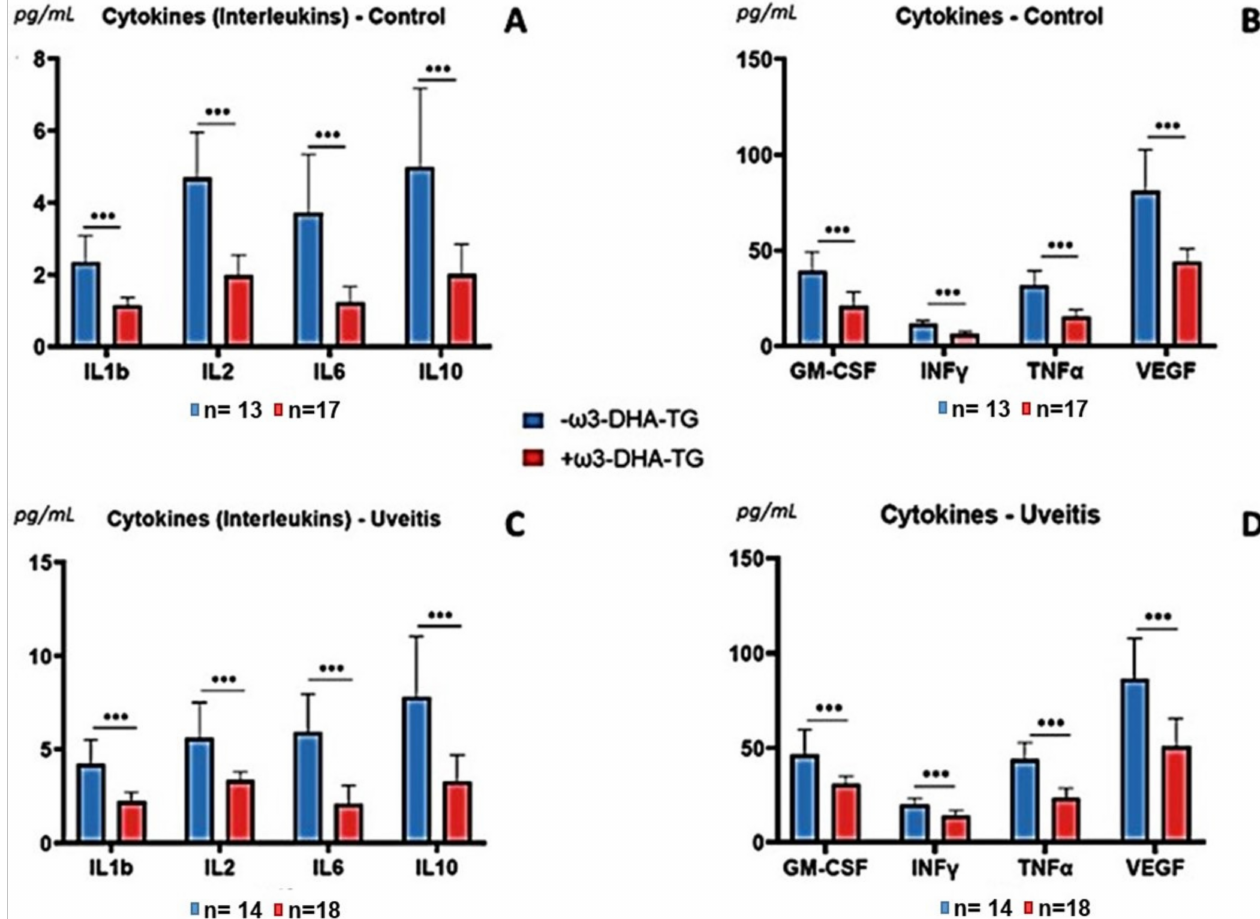
Figure 6. Differential expression profiles of plasma pro-inflammatory mediators in recurrent non-infectious anterior uveitis patients in its quiescent stage and healthy controls, according to the triglyceride form of docosahexaenoic acid regime. ( A ) Plasma level of interleukines in the control group, ( B ) plasma level of other cytokines in the control group, ( C ) plasma level of interleukines in the uveitis group, ( D ) plasma level of other cytokines in the uveitis group. Interleukins: IL -1 β , -2, -6, -10; Granulocyte and macrophage colony stimulating factor: GM-CSF; interferon gamma: INF γ ; tumor necrosis factor alpha: TNF α ; vascular endothelial growth factor: VEGF; with/without omega-3 docosahexaenoic acid: +/ − w3-DHA-TG. Levels are expressed as the mean in pg/mL, and bars represent the standard deviation. Statistically significant *** ( p <